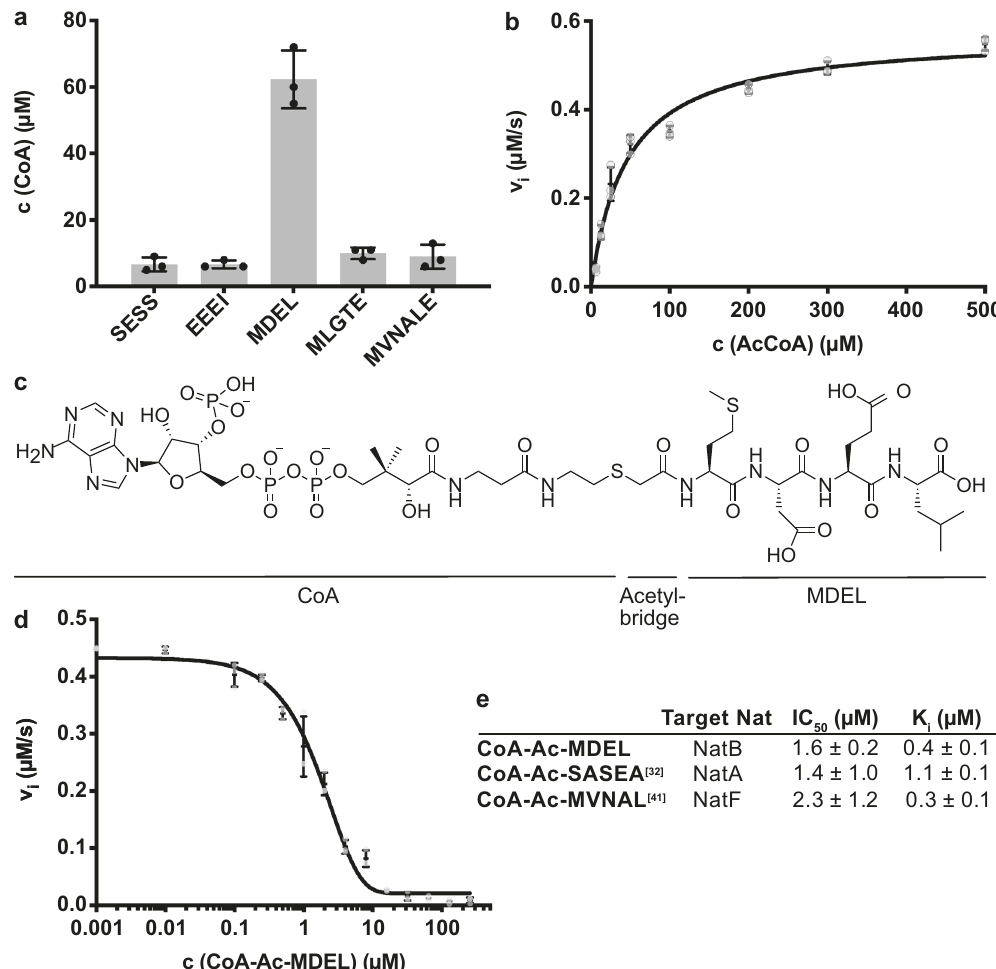
Fig. 2 Ct NatB acetylation activity and inhibition. a Substrate speci fi city of Ct NatB tested with fi ve different peptides. SESS, EEEI, MDEL, MLGTE and MVNALE were previously identi fi ed as NatA, Naa10/Naa80, NatB and NatC/E/F substrates. b Michaelis – Menten curve of the Ct NatB mediated acetylation of MDEL. c Structure of the bisubstrate analog CoA-Ac-MDEL. d Dose-response curve of the NatB mediated acetylation, inhibited by CoA-Ac- MDEL. e Inhibitor characteristics of CoA-Ac-MDEL compared to other bisubstrate analogs 32,41 . All reactions were performed in triplicates and error bars represent the standard